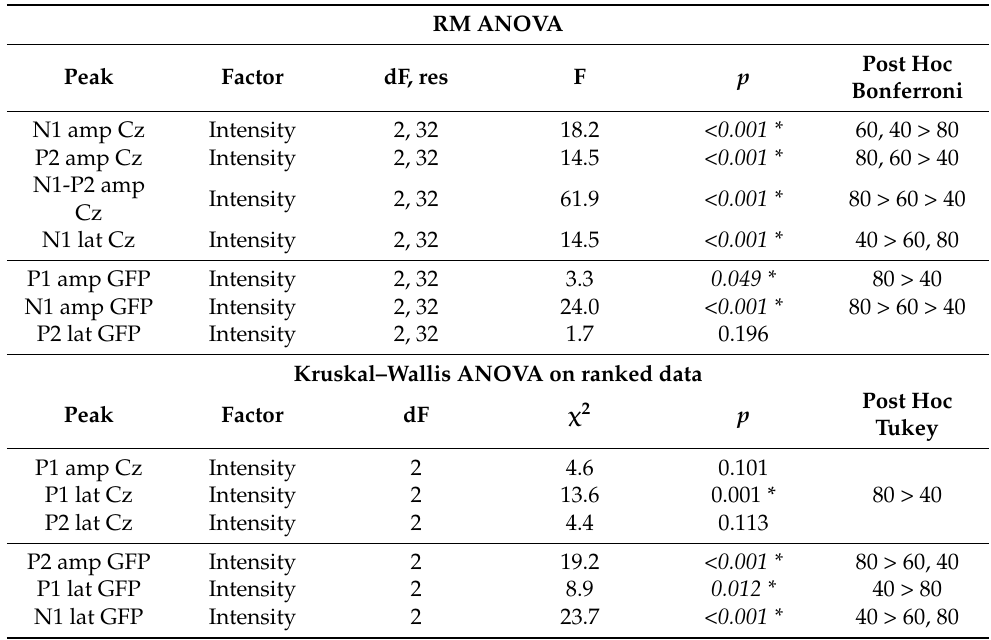
Table 3. Results of RM ANOVAs performed on NH CAEP amplitude and latency data at Cz and for global field power (GFP); in cases where assumptions of normality and equal variance were violated, non-parametric tests were performed (shown in lower part of the table). Significant effects are indicated by asterisks and italics; post hoc significant differences are shown after Bonferroni or Tukey correction for multiple